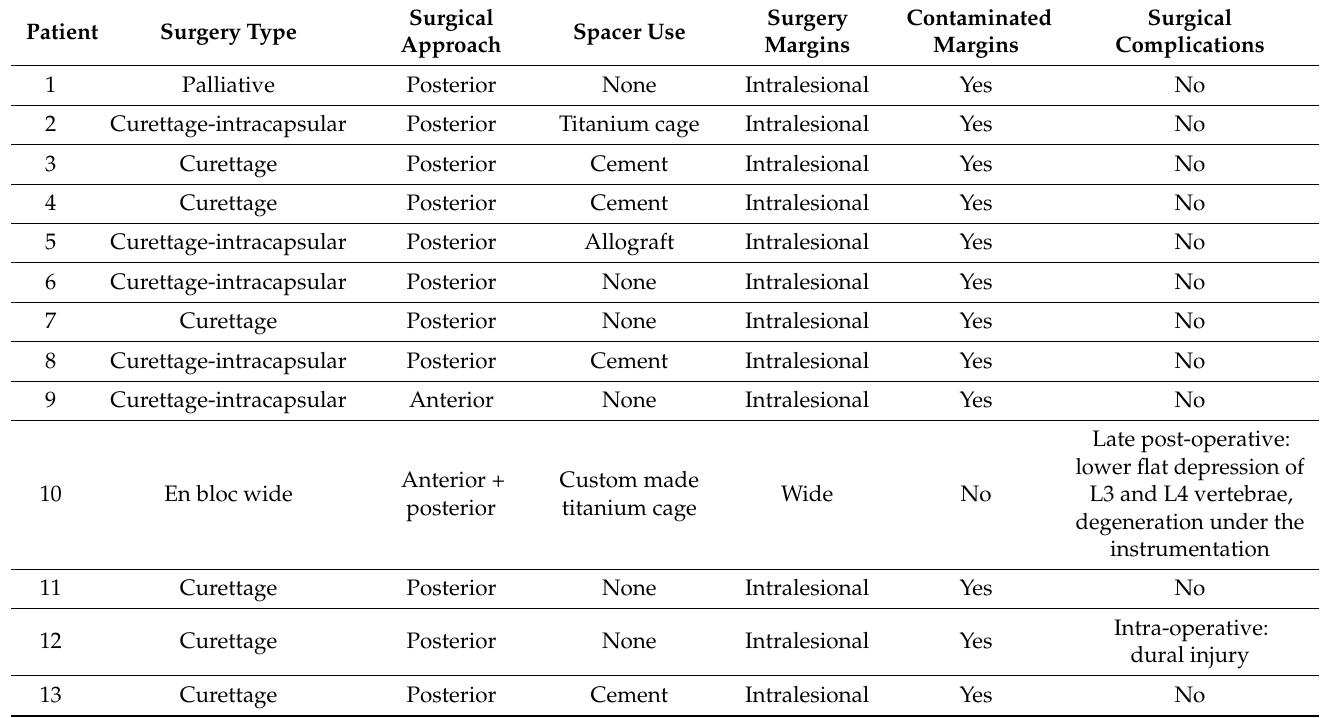
Table 3. Endometrial cancer bone metastasis surgical